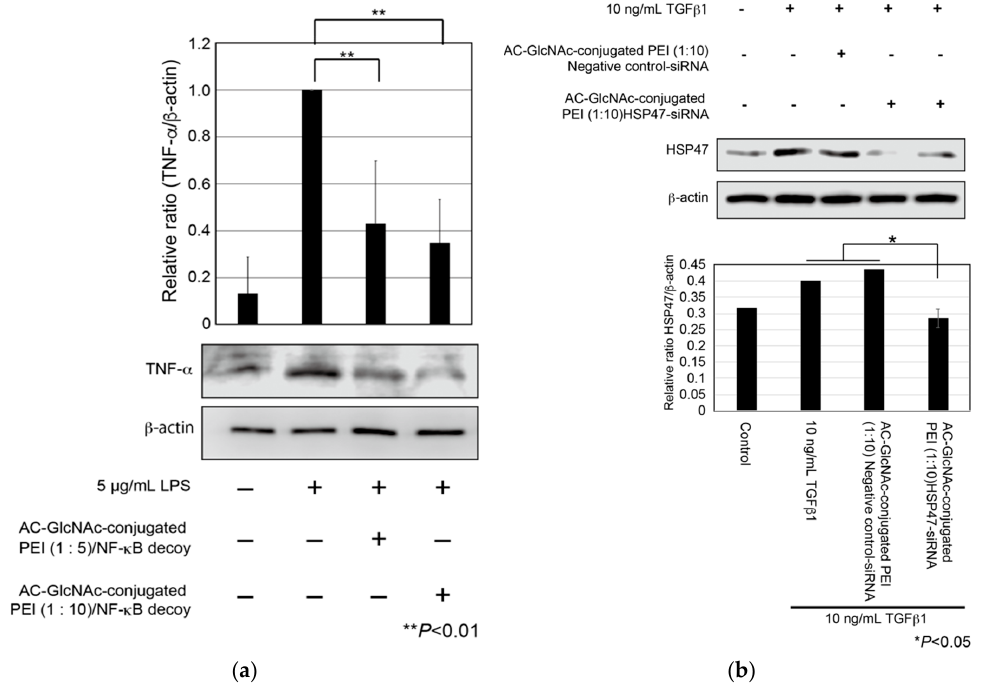
Figure 7. Expression of tumor necrosis factor (TNF)- α in lipopolysaccharide (LPS)-stimulated normal human dermal fibroblasts (NHDFs) and expression of heat shock protein 47 (HSP47) in transforming growth factor- β (TGF- β )-stimulated NHDFs. ( a ) TNF- α secreted from the NHDFs in the culture media was detected by Western blotting. ( b ) Expression of HSP47 in TGF- β -stimulated NHDFs. These graphs show TNF- α and HSP47 expression levels determined by densitometry. TNF- α and HSP47 expression levels were normalized against β -actin expression levels.